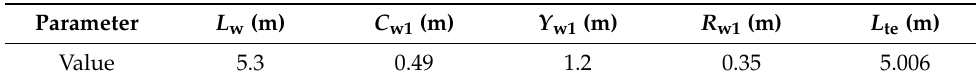
Figure 6. Details of the wing 1 model. Table 2. Main dimensions of wing 1. Table 2. Main dimensions of wing 1.